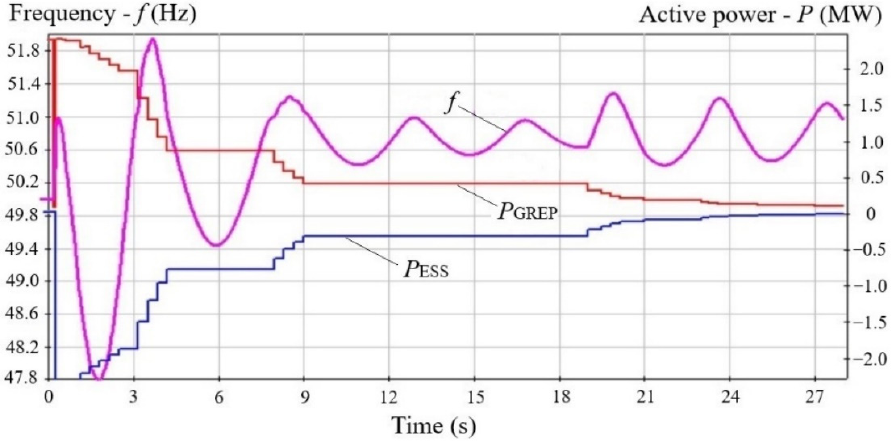
Figure 5. Transient in the case of shedding 95% of the initial GREP load.